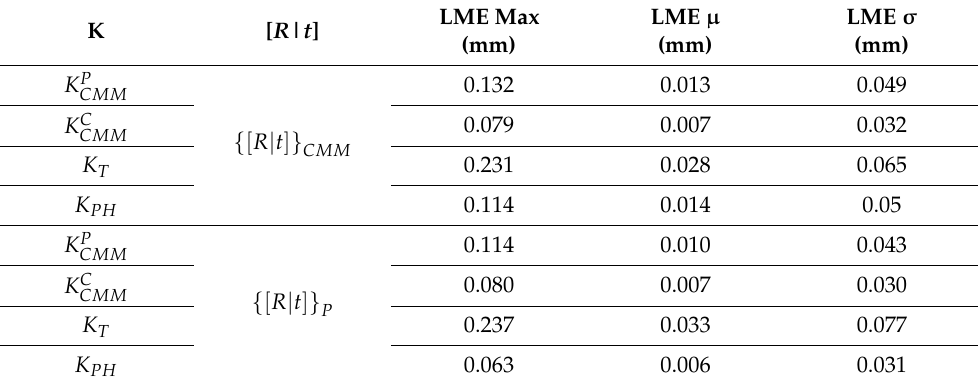
Table 8. The photogrammetry intrinsic calibration is included within the different calibration